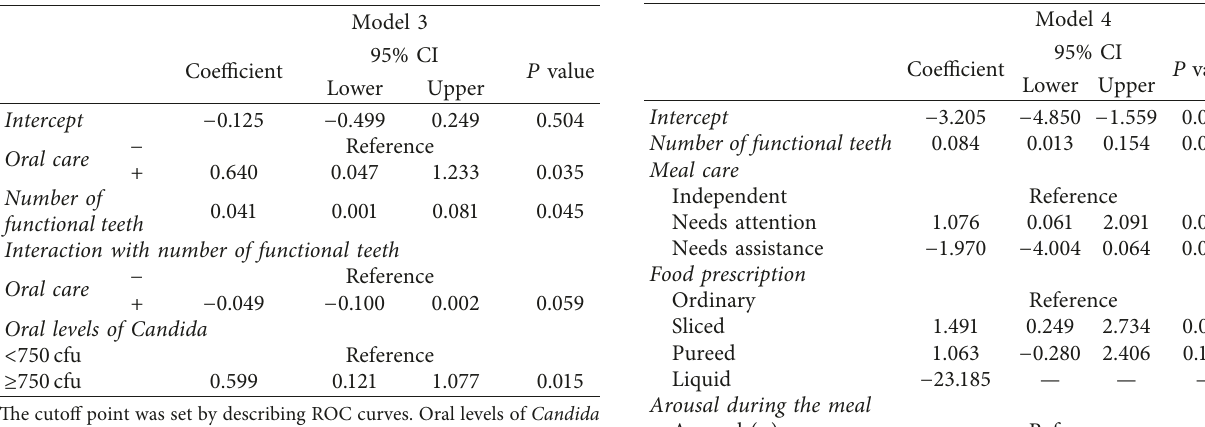
Table 4: Risk factors for fever among the subjects receiving the oral care